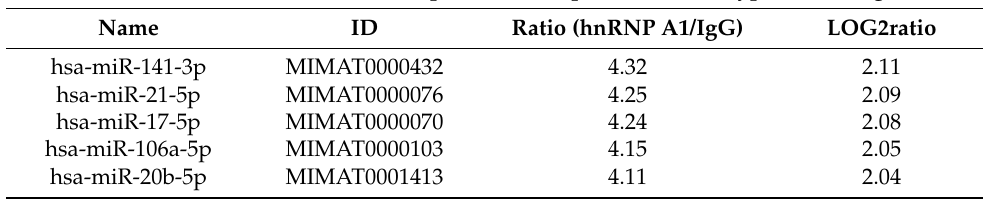
Table 2. Cont. miRs with Greater than 4-Fold Expression Compared to the Isotype Control